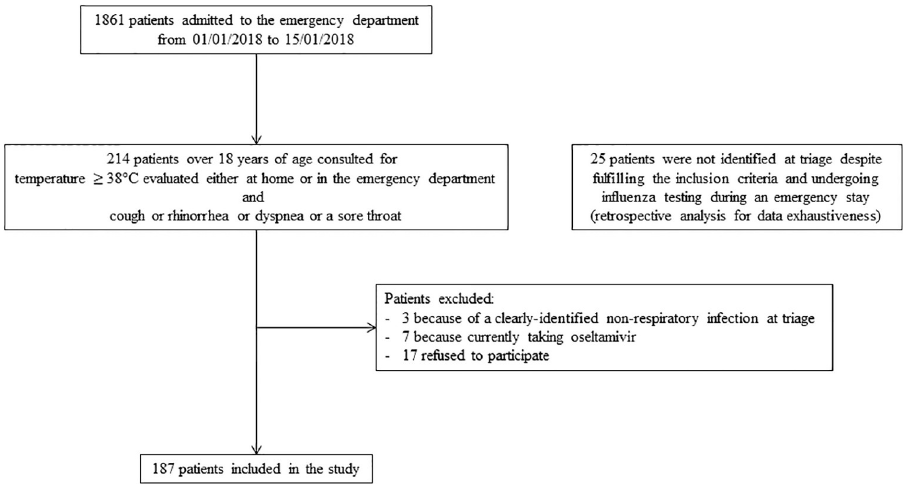
Fig 1. Study flow